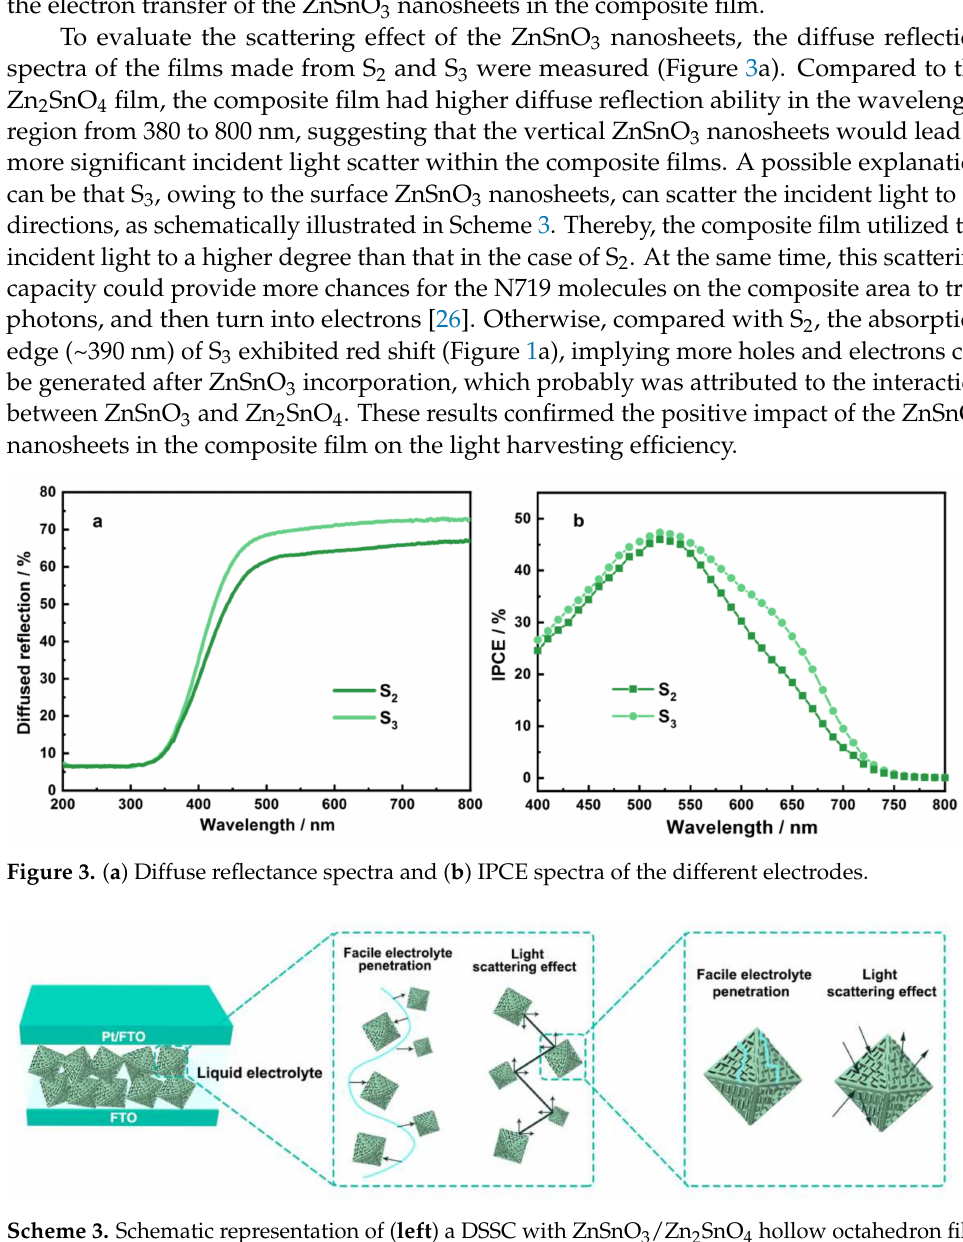
Scheme 3. Schematic representation of ( left ) a DSSC with ZnSnO 3 /Zn 2 SnO 4 hollow octahedron